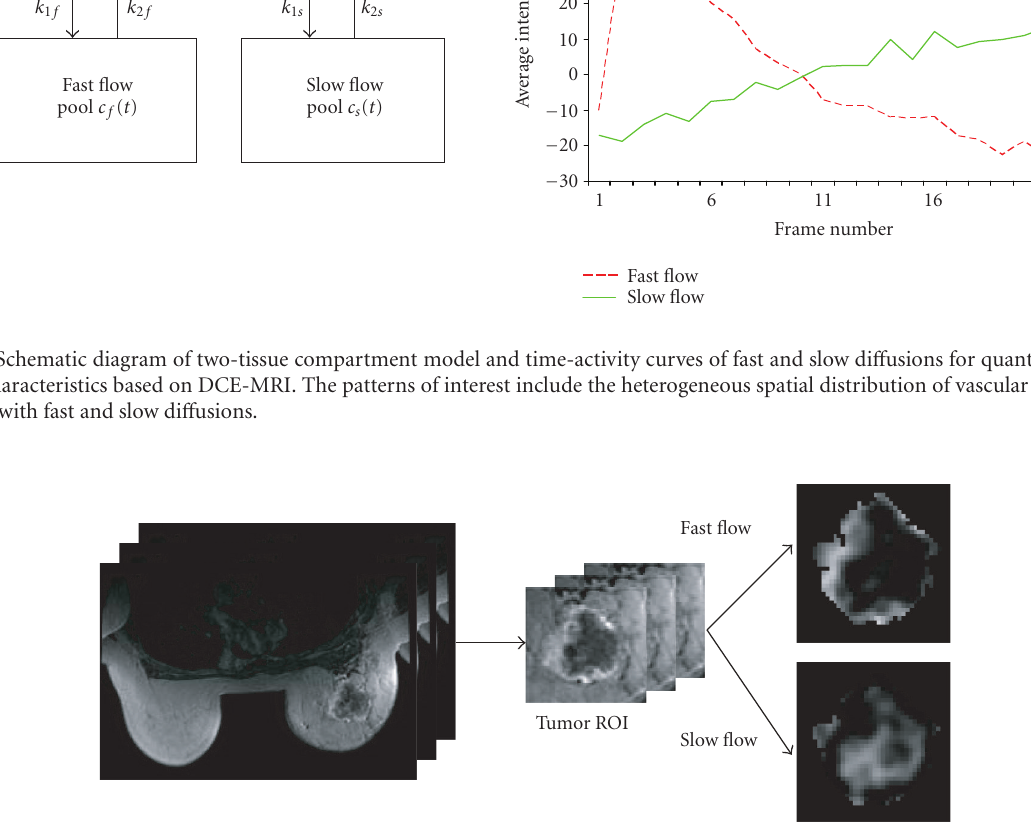
Figure 2: Illustration of source pattern mixing